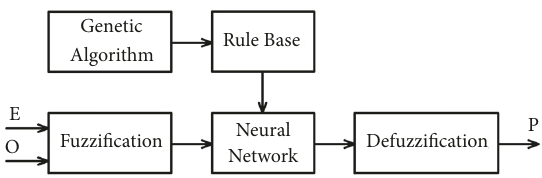
Figure 2: Architecture of the genetic neurofuzzy